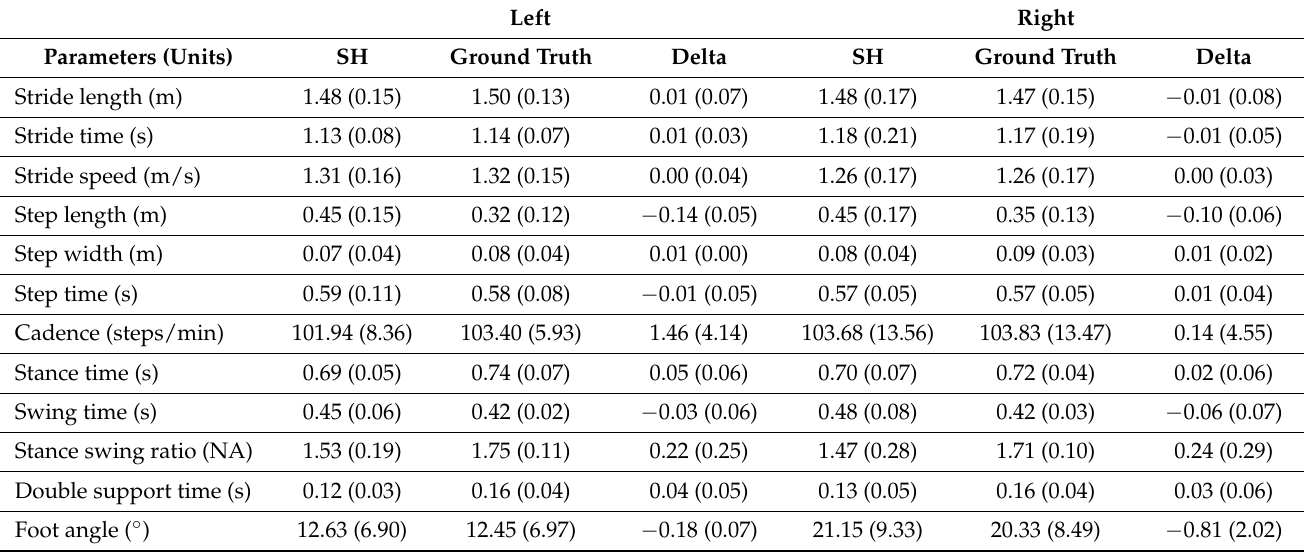
Table A7. Stride parameters for participant two: walking-straight test (mean and standard deviation in brackets). Left Right